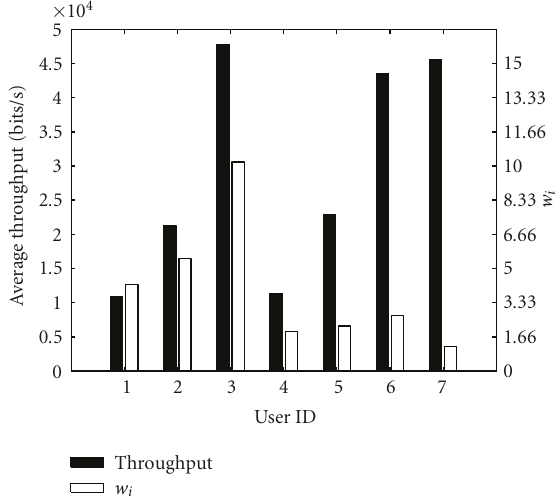
Figure 7: Average throughput under di ff erent QoS requirements (weights) by MAX-FAIR.